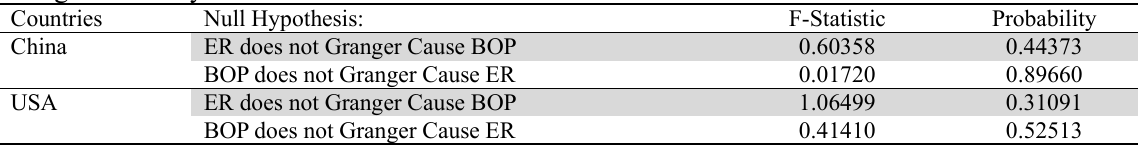
Granger Causality Test